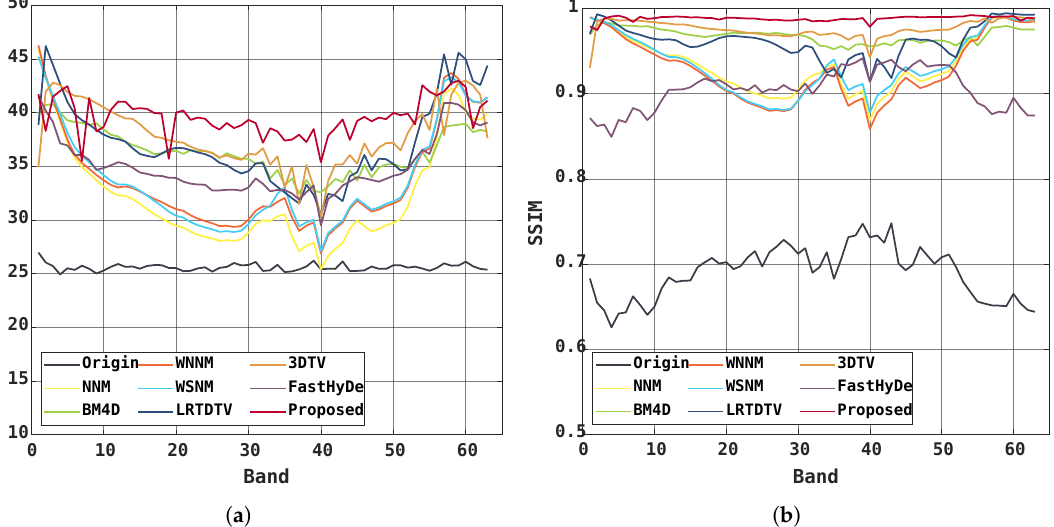
Figure 12. The line charts of the denoising efficiency vary with the waveband compared with existing methods on the SFD dataset (Case 5_2): ( a ) PSNR (dB); and ( b )